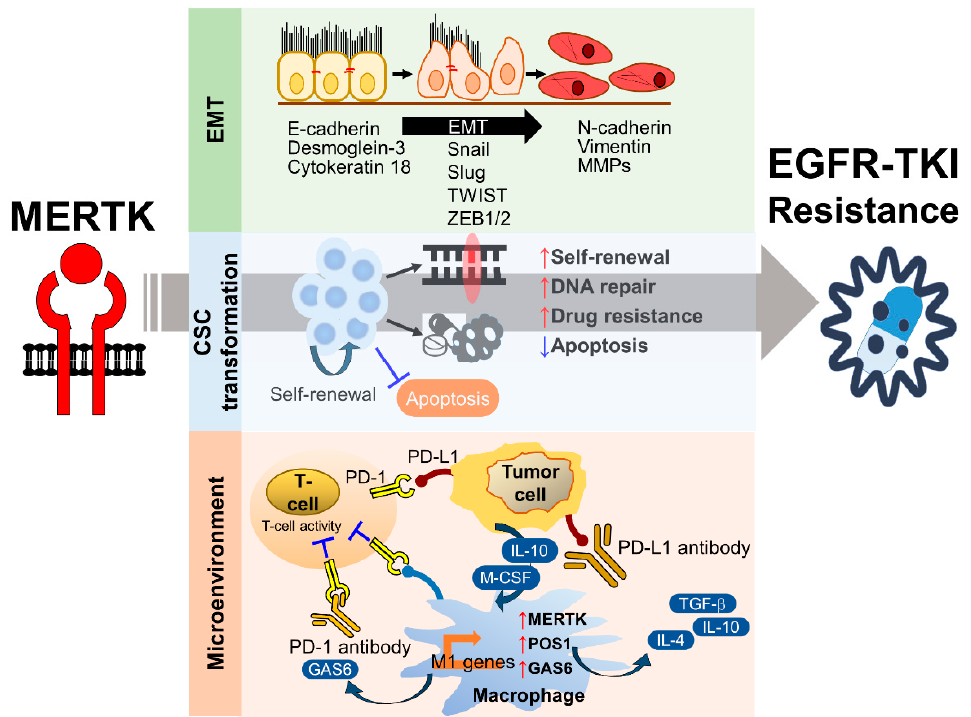
Figure 4. The mechanisms of MERTK-mediated EGFR-TKI resistance. The activation of MERTK contributes to epithelial-to-mesenchymal transition (EMT), cancer stem cell (CSC) maintenance, and the immunosuppressive microenvironment, which are the major biological factors involved in the development of EGFR-TKI resistance.